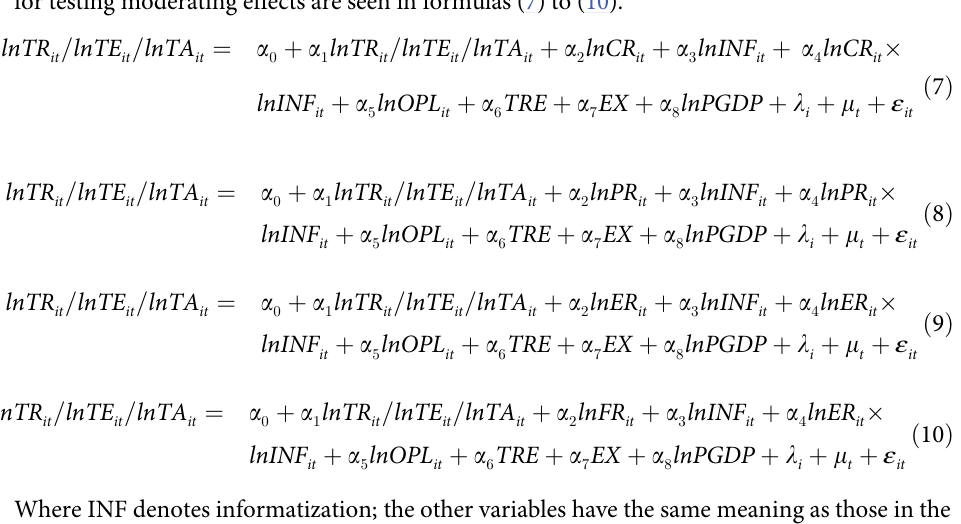
Table 3. Unit root test.